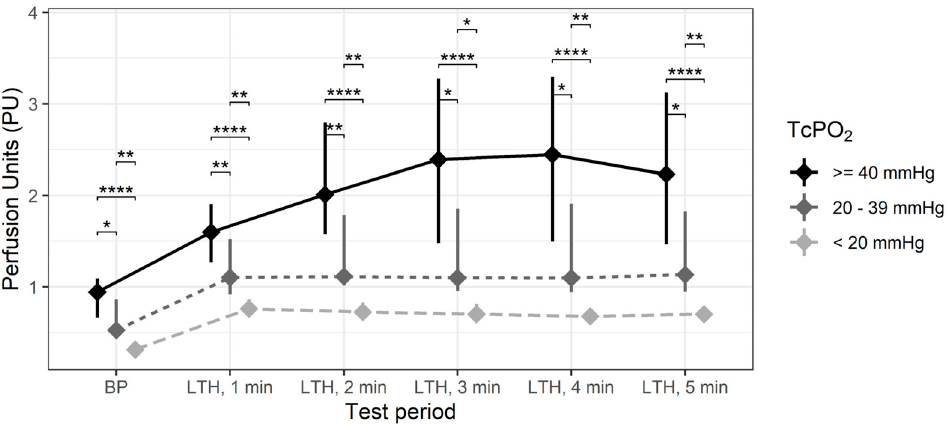
Figure 3. Median and interquartile ranges of perfusion measured by IOFF at different time points